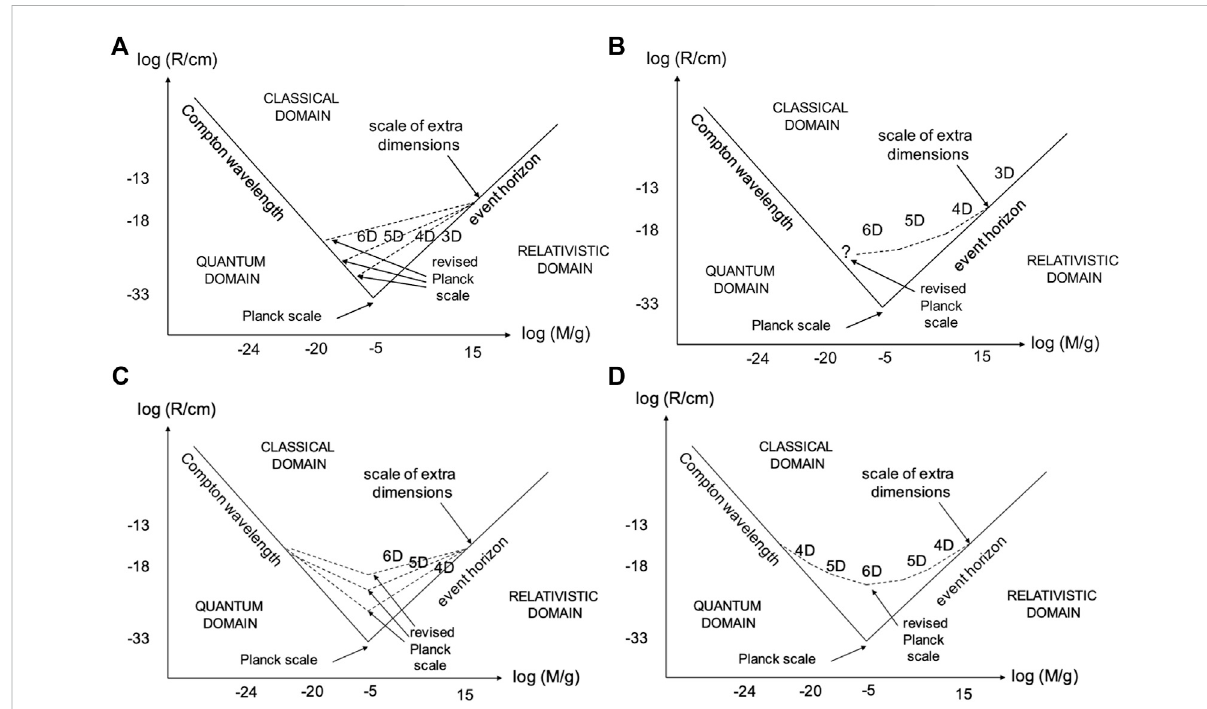
FIGURE 5 Modi fi cation of the Schwarzschild line and Planck scales in the ( M , R ) diagram for extra compact dimensions associated with (A) a single length scale or (B) a hierarchy of length scales (B) if the Compton scale preserves its usual form. (C) and (D) are the corresponding diagrams if the duality between the Compton and Schwarzschild expressions is preservd. From Lake and Carr